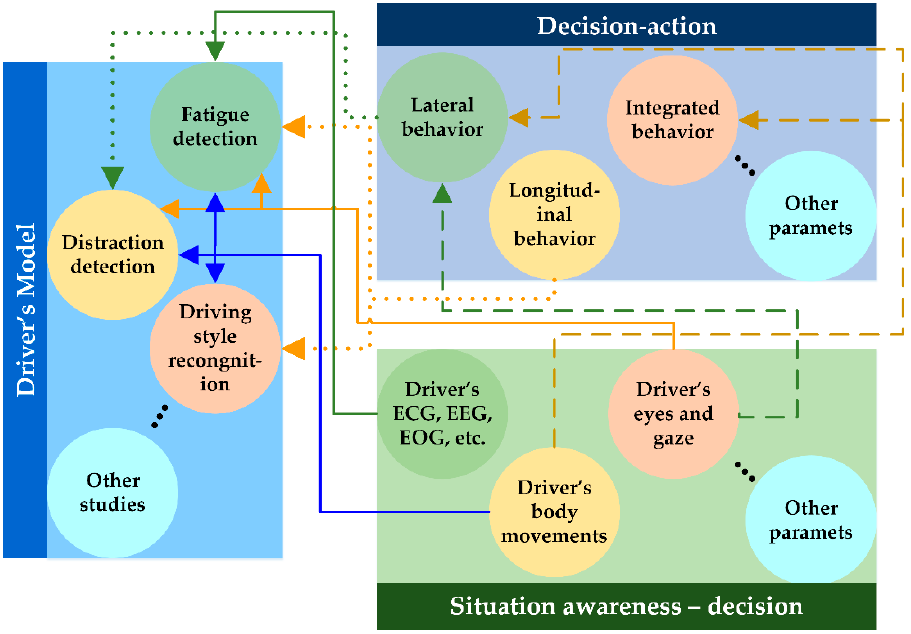
Figure 2. Interconnection of research areas.